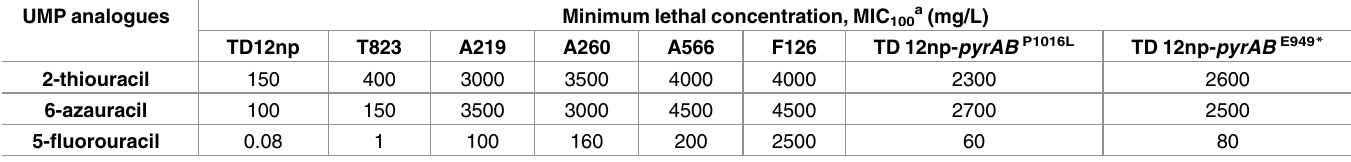
Table 1. Effect of UMP analogues on the growth of parent and mutant strains. UMP